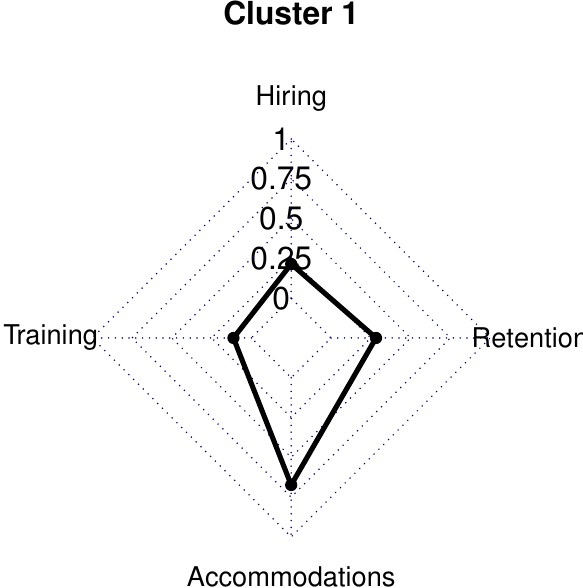
Figure 2. Cluster 1 radar